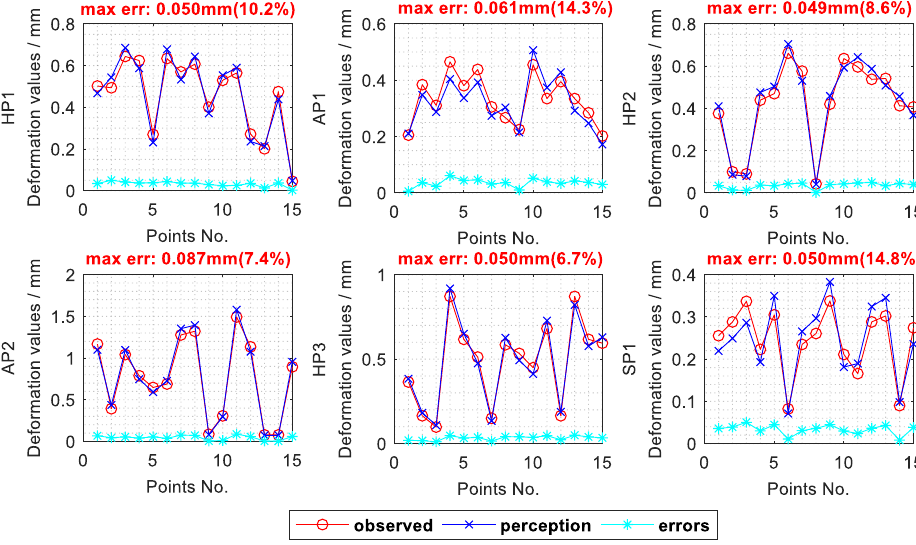
Figure 11. Comparison between the results of actual monitoring and model perception.